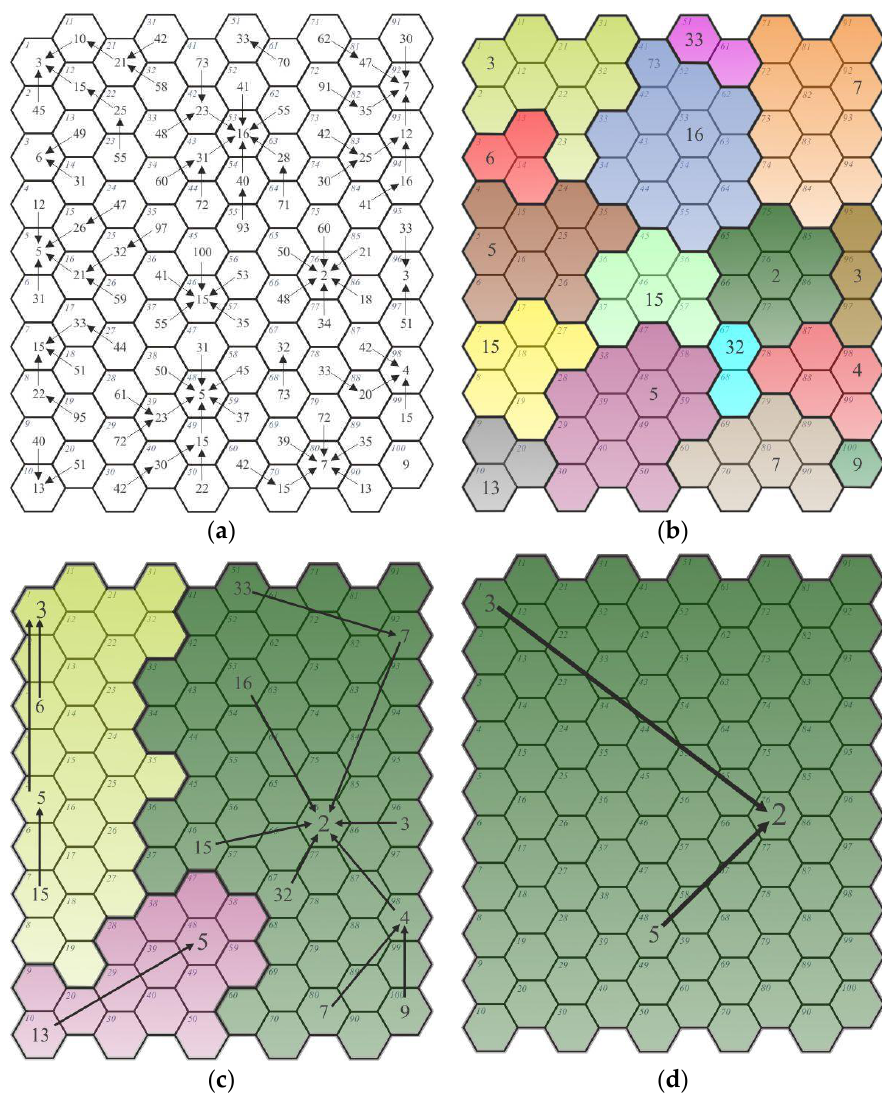
Figure 4. The stages of network emergence according to the maximum value decrease path: ( a ) the stage of revealing the maximum value decrease relationship; ( b ) the first stage of value aggregation; ( c ) the second stage of value aggregation; ( d ) the third stage of value aggregation. Source: Own analysis.